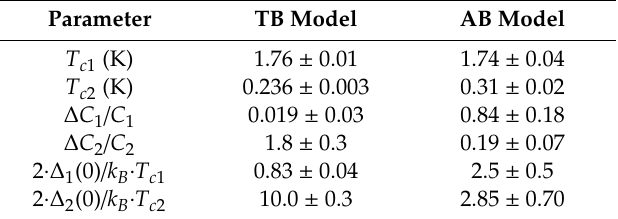
Table 3. Deduced parameters for Nb / BiSbTeSe 2 -nanoribbon / Nb junction (Sample 1 [56]) at V g = − 20 V from fit to two-band Titov and Beenakker (TB) [53] and Ambegaokar and Barato ff (AB) [7,8] models.